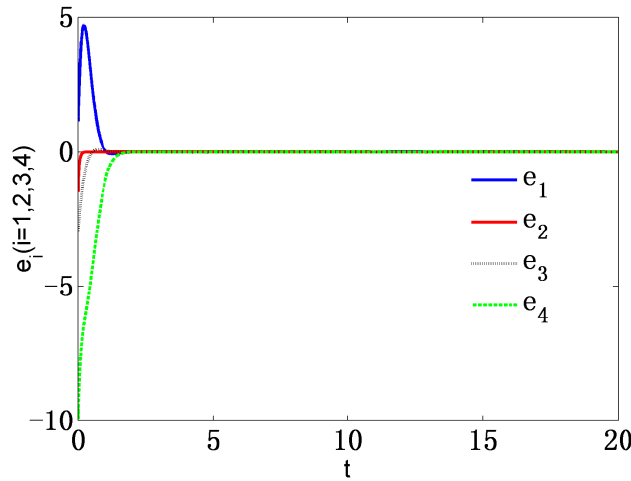
Figure 13. Curves of errors in system (9) with controllers (8).